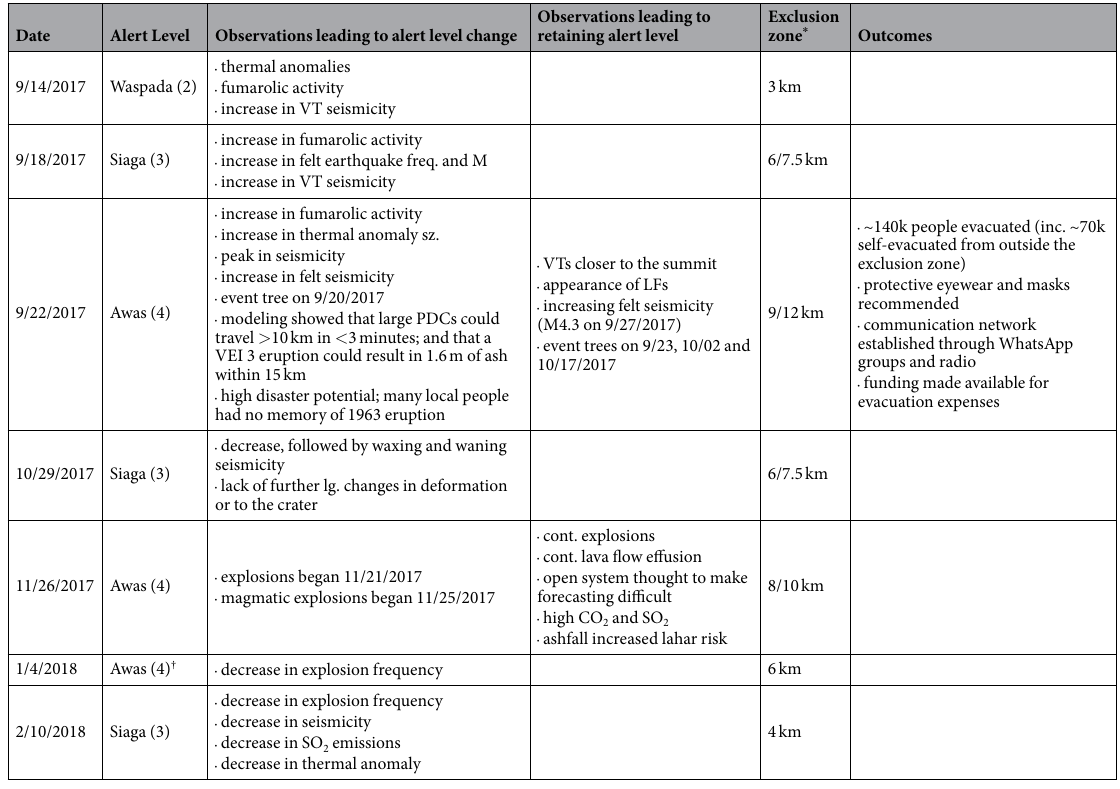
movement toward the volcano, while a station to the northwest (CEGI) registered movement away from the vol- cano. The change to Level 4 (Awas) triggered evacuations. RSAM values then declined, but elevated seismic event rates, including large magnitude earthquakes (up to M4.2), persisted. On 7 October, a notable white-colored gas plume rose from the northeast crater floor ~1500 m above the summit crater, lasted for about an hour, and was detected seismically (Fig. 3F). This was the tallest plume observed before the eruption. Unauthorized climbers reported sulfur smells, rumbling noises, and fumarolic activity from the northeast crater floor. However, SO 2 emissions were below the detection limit as measured by mobile DOAS at 12 km distance (Fig. 2E). 29 October 2017–– Downgrade to Level 3: Seismic event rates declined sharply on 20 October, though VTs started to move closer to the summit (proximal events). With the decrease in seismic event rates and the long (one-month) duration of evacuations, the alert level was lowered to Siaga (Level 3) on 29 October. In early November, RSAM values began to increase slowly (Figs 2B and 3). On 8 November, an M4.9 earthquake was recorded and was felt by people (Modified Mercalli Intensity, MMI II–V) as far as ~60 km from the volcano. This was the largest recorded VT event during the crisis period (Figs 2B and 3). 26 November 2017–– Upgrade to Level 4: In mid-November, LF events and tremor appeared, and seismic event locations moved closer to the volcano. Drone flights fitted with a multi-GAS above the volcano’s crater detected a CO